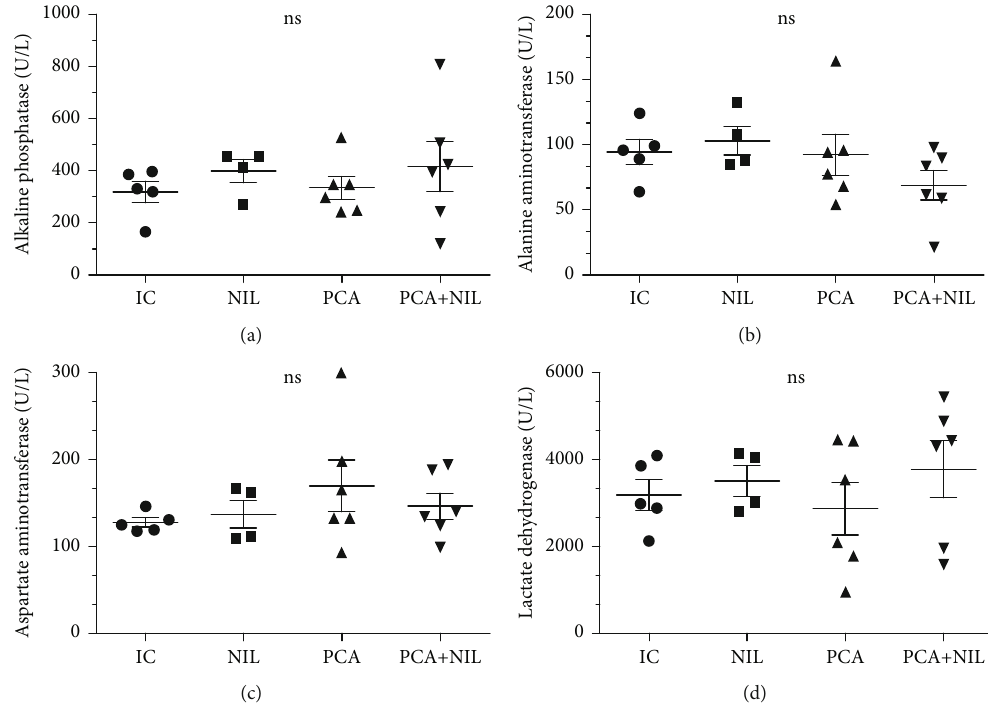
Figure 4: E ff ects of neurointermediate pituitary lobectomy (NIL), portacaval anastomosis (PCA), and PCA+NIL on (a) alkaline phosphatase (AP), (b) aspartate aminotransferase (AST), (c) alanine aminotransferase (ALT), and (d) lactate dehydrogenase (LDH) serum levels. Nonstatistical di ff erences between groups were apparent. The intact control (IC) group served as reference. It was evaluated with analysis of variance test with the Tukey post hoc values, which are expressed as the mean ± SD